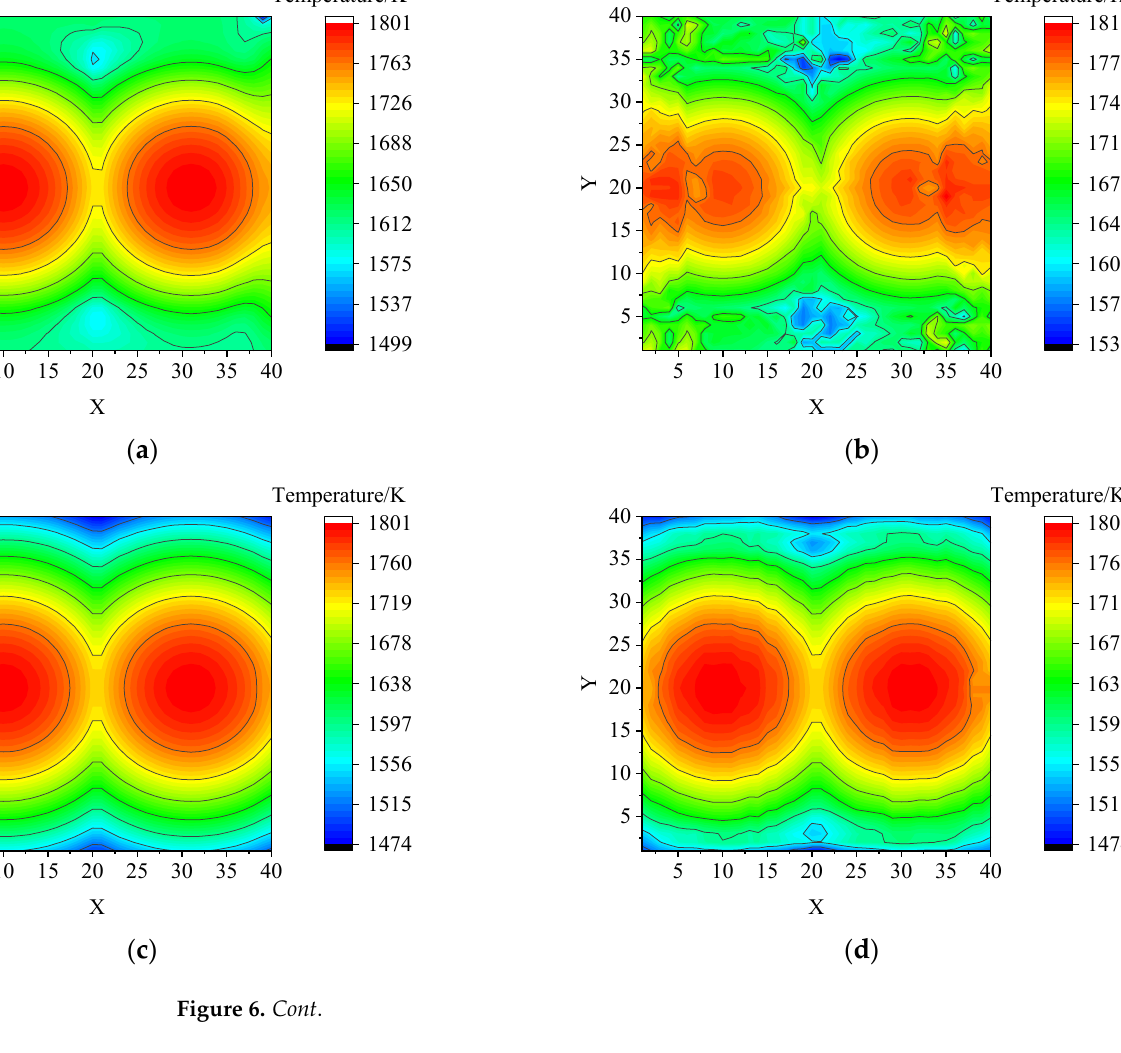
( f ) Figure 6. Reconstruction results of the two algorithms with different numbers of cameras: temper- ature-reconstruction results of the regularization algorithm at four cameras ( a ), six cameras ( c ) and twelve cameras ( e ) and the results of the LSQR algorithm at four cameras ( b ), six cameras ( d ) and twelve cameras ( f ). ( a )